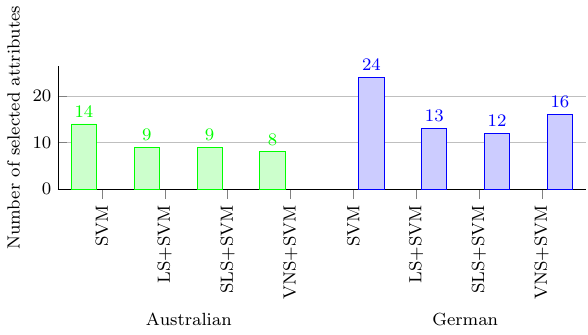
Fig. 6 Comparison in term of the number of selected